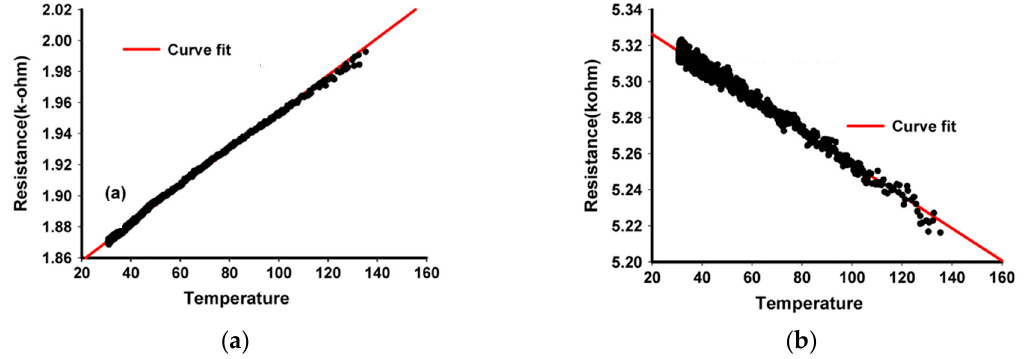
Figure 6. Sensor temperature–resistance curves for MWCNTs grown with ( a ) 0.9 µm and ( b ) 1.8 µm gap between electrodes. © 2007 IEEE. Reprinted, with permission, from [54]